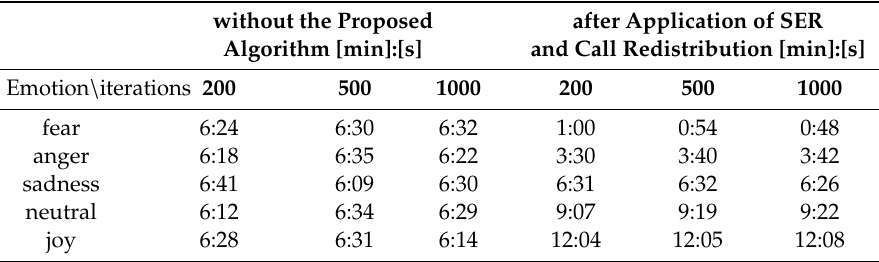
Table 8. Average waiting time when 7 calls are received simultaneously while all operators are